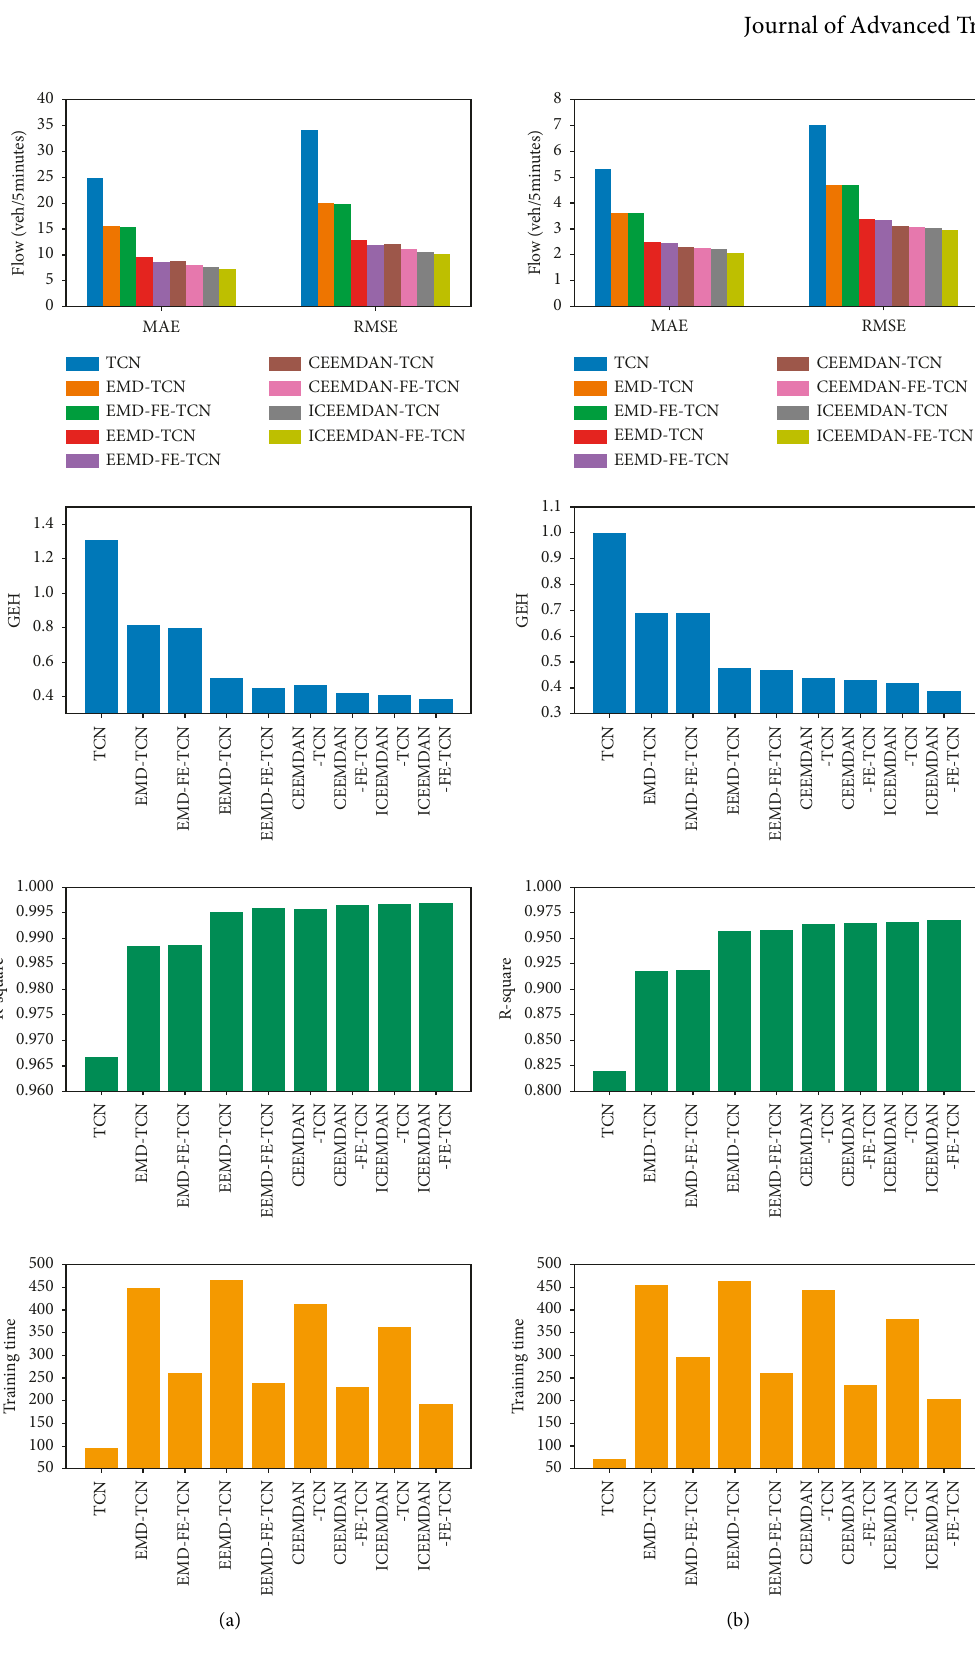
Figure 10: Prediction performance of different models based on TCN: (a) 717490 and (b)